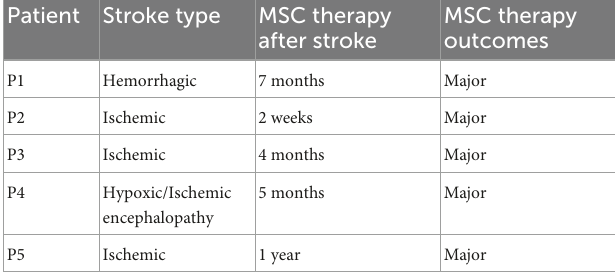
TABLE 5 Mesenchymal stem cells (MSCs) transplantation information according to patients’ stroke history. Patient Stroke type MSC therapy MSC therapy after stroke